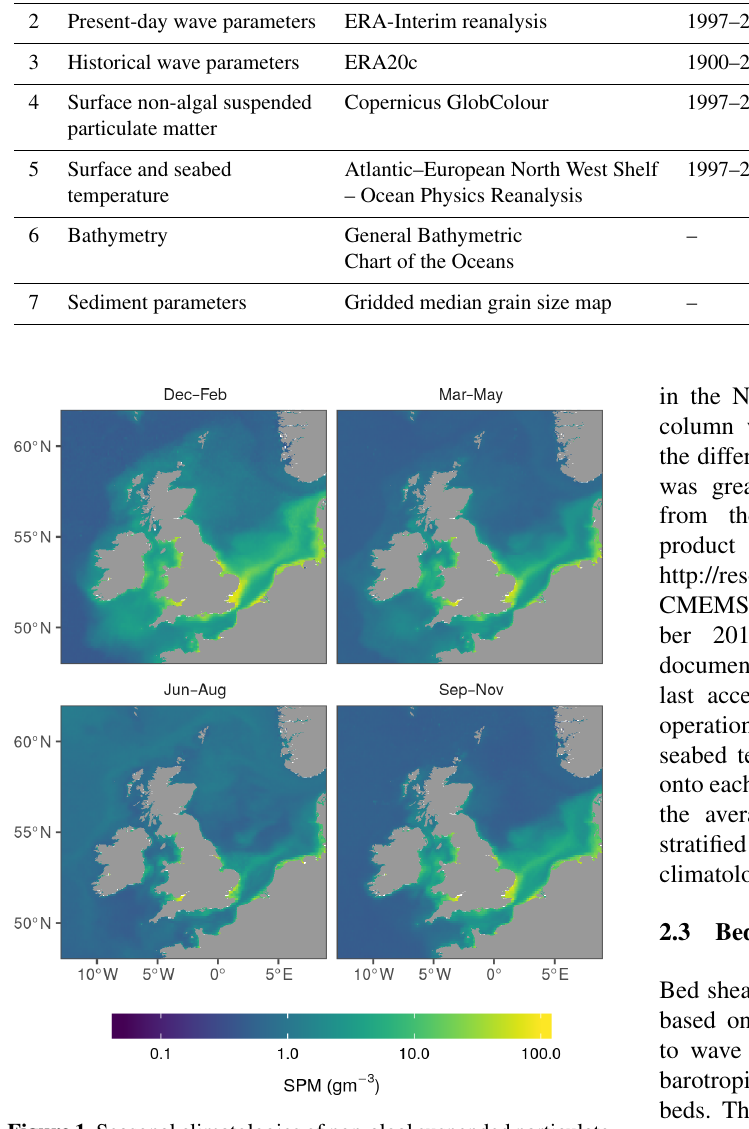
Figure 1. Seasonal climatologies of non-algal suspended particulate matter at the water surface for the period 1997–2017. SPM was cal- culated from Copernicus GlobColour estimates, which are derived from remote sensing data using the Gohin (2011)